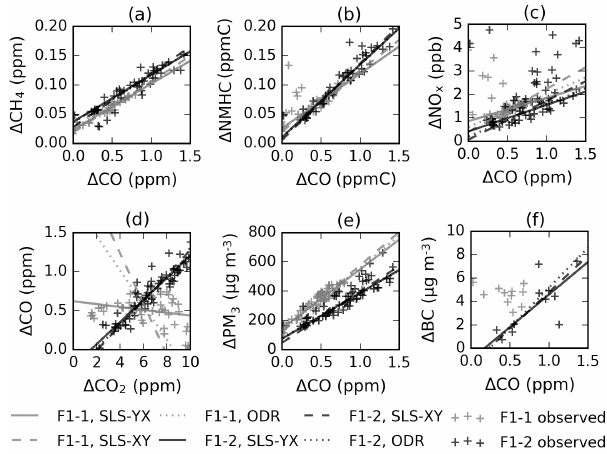
Figure 5. Excess levels of trace gases and particles versus excess mixing ratios of CO or CO 2 for F1 plume parts, with lines fitted to the data by different regression methods (see explanations in the text).